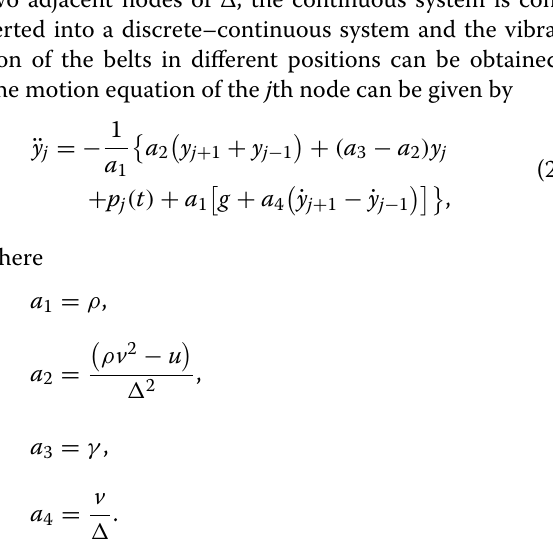
pulley, while the transverse vibration is the vibration in the direction perpendicular to the center line. The transverse